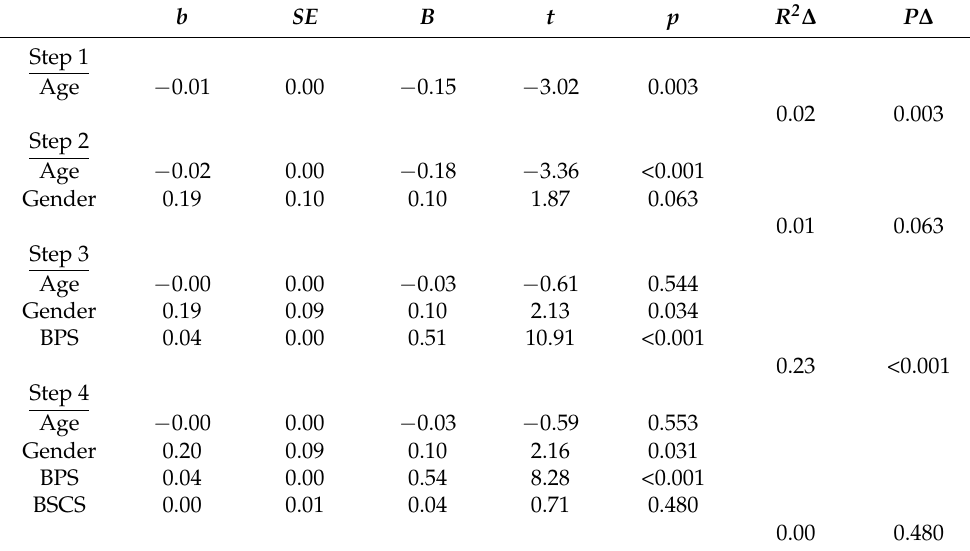
Table 4. Hierarchical regression predicting COVID-19